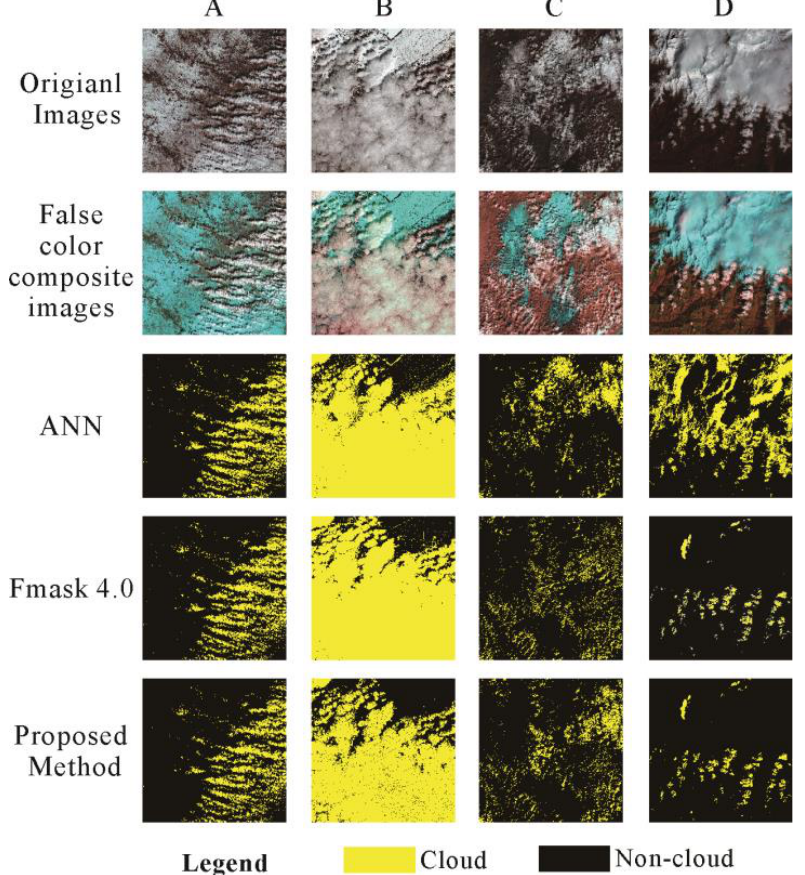
Figure 6. Comparison of the proposed method against ANN and Fmask. (Sub-figures ( A – D ) corre- spond to the four data used in this paper, respectively. Cropping the region of interest, a false color composite is used to help the reader visually differentiate between snow/ice and clouds. Bands 7, 4, and 2 for Red, Green, and Blue, respectively).